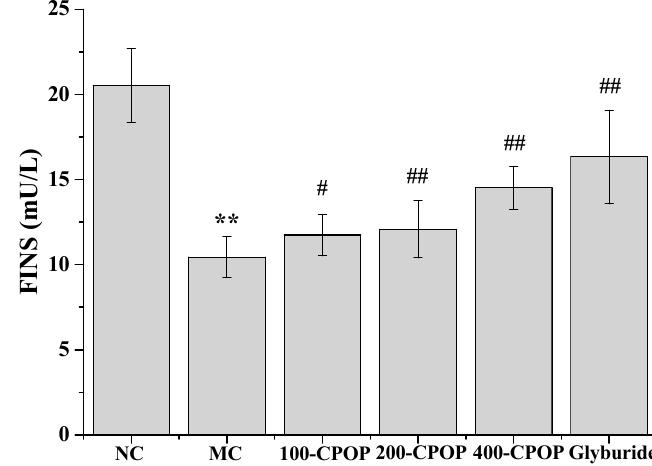
Figure 4. Effect of CPOP on Fasting Serum Insulin (FINS) in STZ-induced diabetic rats. ** p < 0.01 vs. NC group ( N = 8); # p < 0.05, ## p < 0.01 vs. MC group ( N = 8). NC is the normal control group; MC is the model control group; 100-CPOP is the 100 mg/kg per body weight CPOP group; 200-CPOP is the 200 mg/kg per body weight CPOP group; 400-CPOP is the 400 mg/kg per body weight CPOP group.